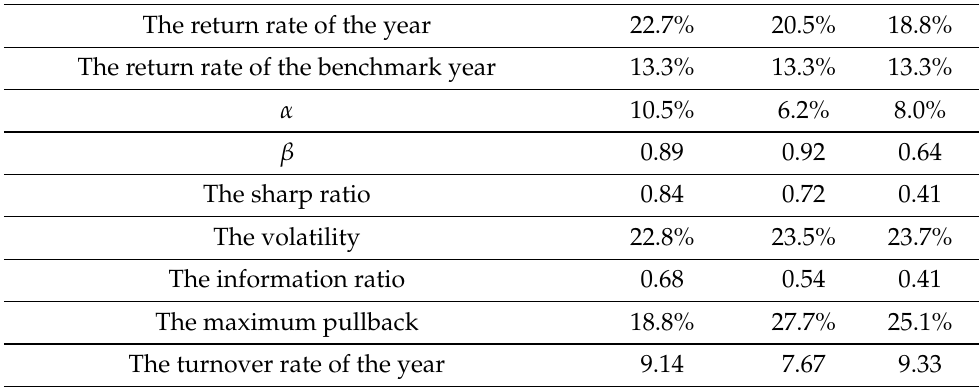
Table 3. The back test